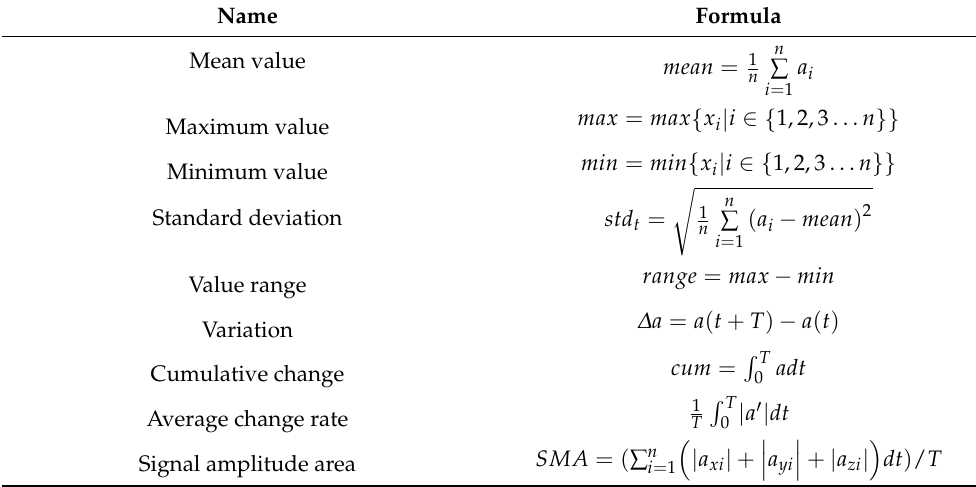
Table 2. Time domain